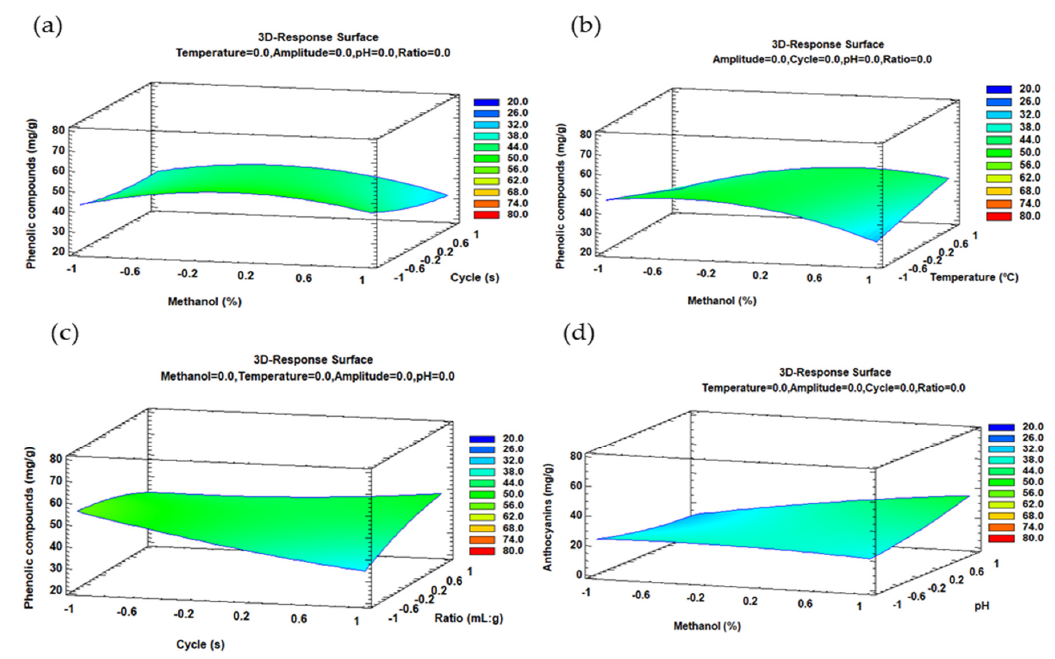
Figure 2. 3D-surface plots of the Box–Behnken design to represent the influence of: ( a ) Solvent composition and cycle on the total phenolic compounds; ( b ) solvent composition-temperature on the total phenolic compounds; ( c ) cycle-ratio on the total phenolic compounds; ( d ) solvent composition-pH on the total anthocyanins.